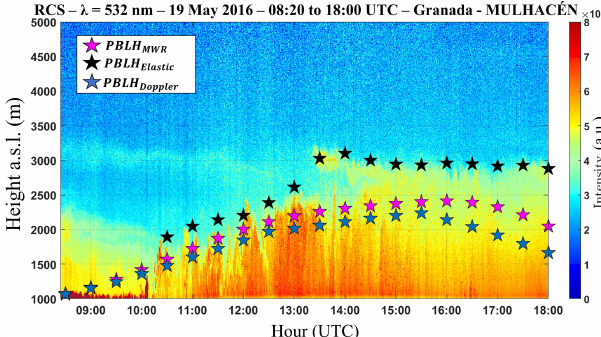
Figure 11. Time–height plot of RCS obtained on 19 May 2016 in Granada. Pink stars represent the PBLH MWR , black stars represent the PBLH Elastic and blue stars represent the PBLH Doppler